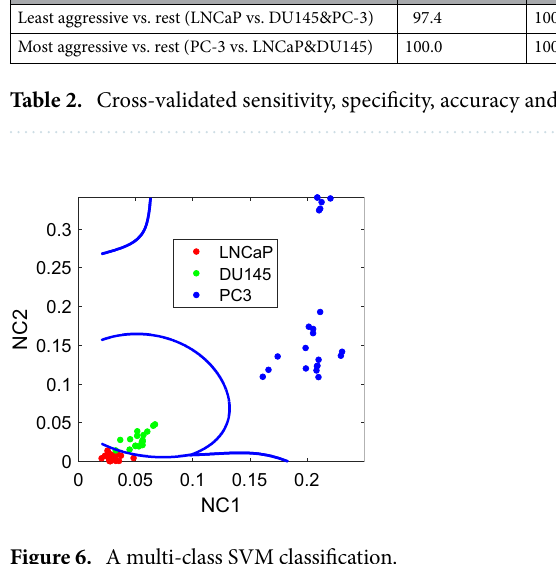
Figure 6. A multi-class SVM classification.